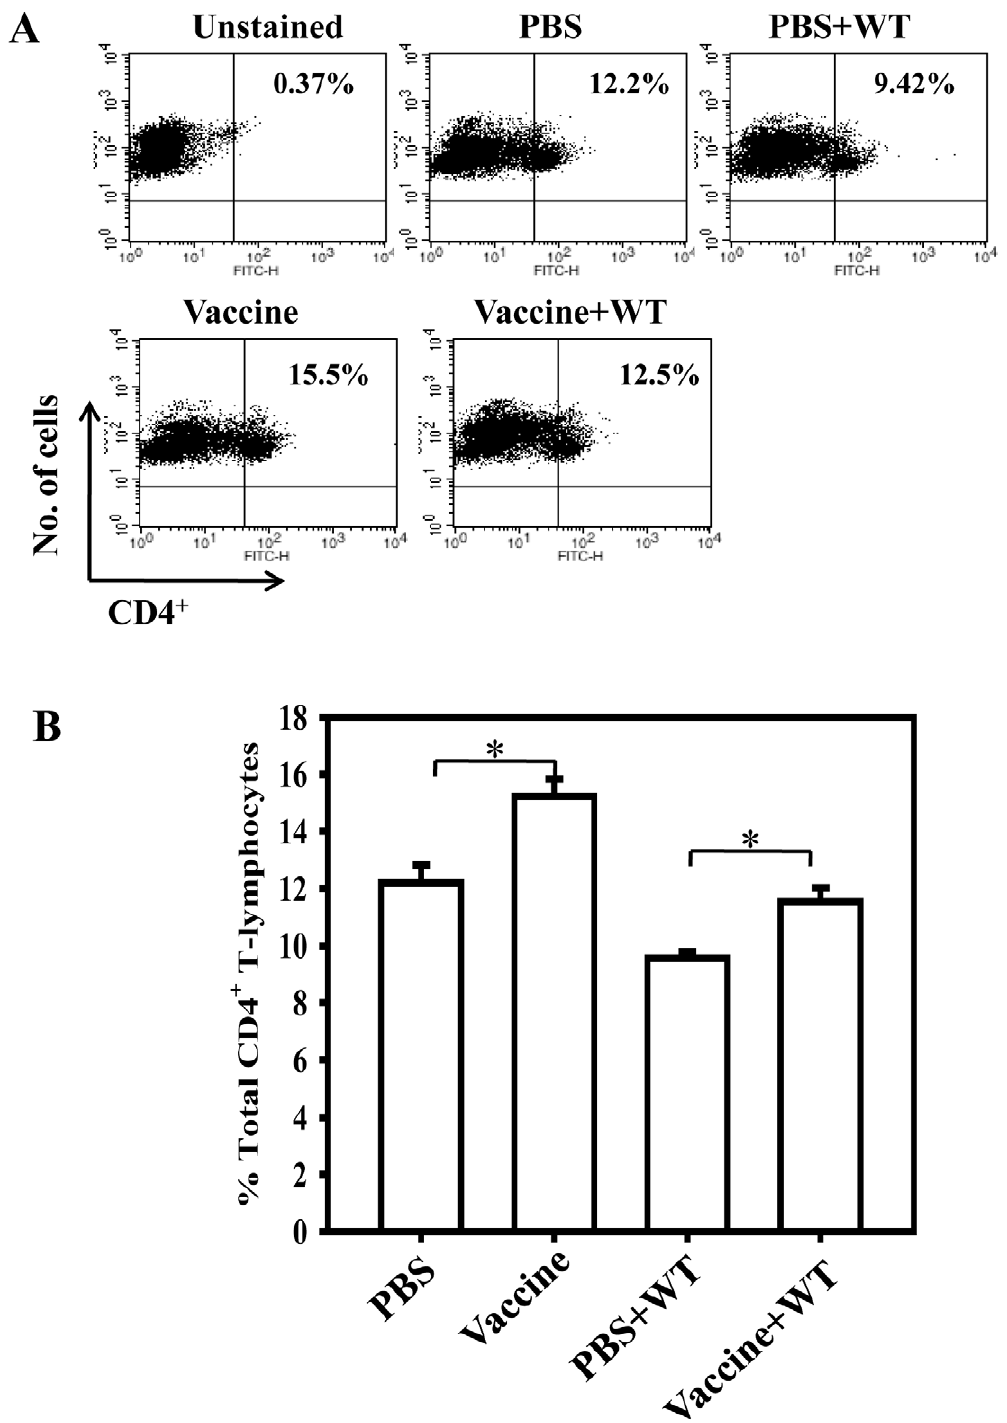
Figure 6. Analysis of splenic CD4 + T cell population in vaccinated and unvaccinated mice with or without challenge. Group of mice were orally given PBS or 10 8 STM D hfq bacteria and then challenged with 10 7 CFU of the STM-WT per mouse. On 7 th day post vaccination and 7 th day post challenge, single cell suspension of splenocytes were prepared and stained with FITC-conjugated anti-CD4 MAb. The relative levels of CD4 + T- lymphocytes were measured through FACS. Data was analysed by BD Cell-Quest software and represented through dot plot (A) and bar graph (B). Statistical significance was defined as follows: (* p , 0.05) (Student’s t test). Each group consisted of 4-5 mice. doi:10.1371/journal.pone.0016667.g006 Typhimurium hfq mutant was attenuated in competition with the parental strain in an intraperitoneal infection of BALB/c mice and that the bacterial recovery was also low after oral infection.